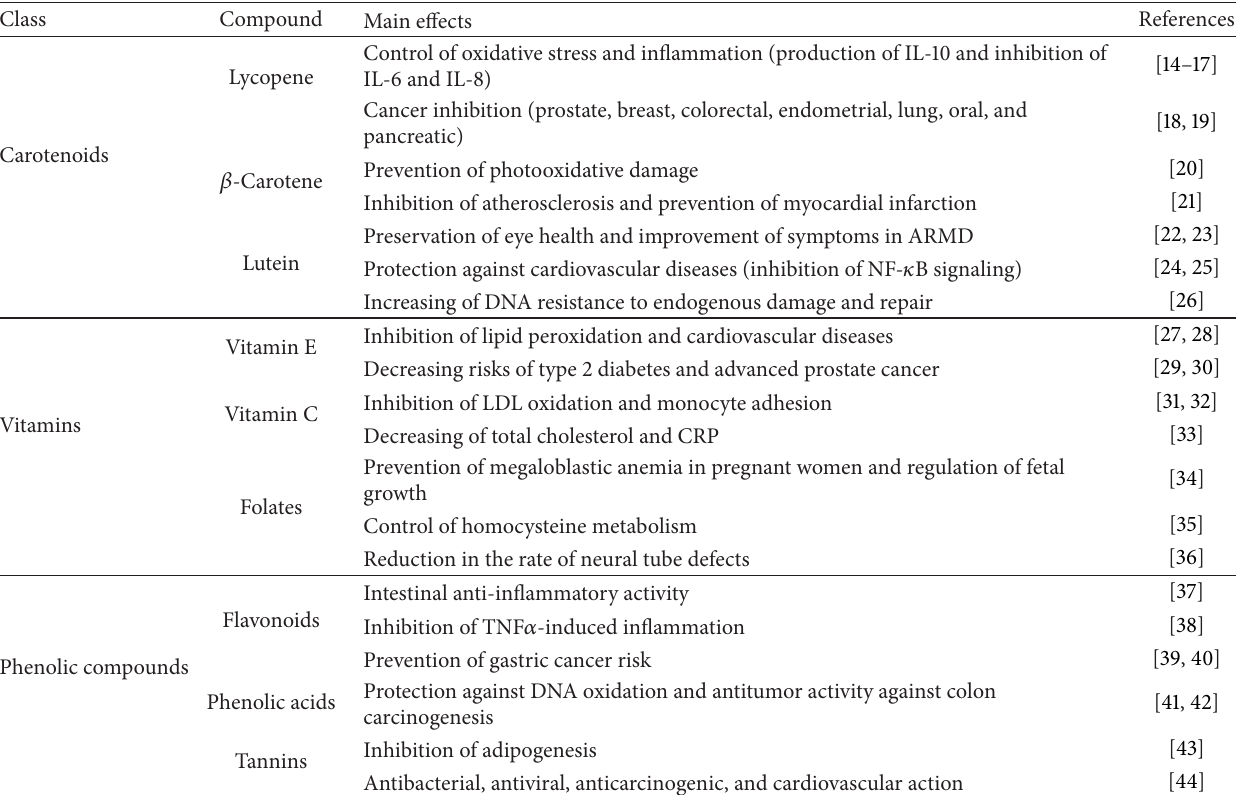
Table 1: Effects of bioactive compounds occurring in